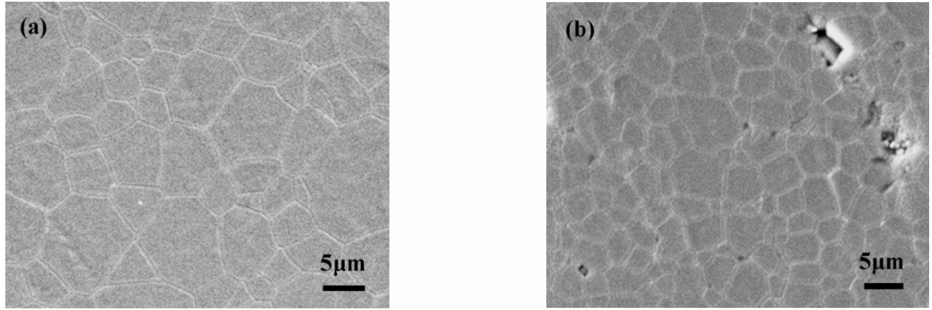
Figure 12. Thermally etched surface morphologies of (Y 0.94 Yb 0.06 )AG ceramics sintered at 1700 ◦ C, ( a ) the precursor not laying aside, ( b ) the precursor laying aside a month.